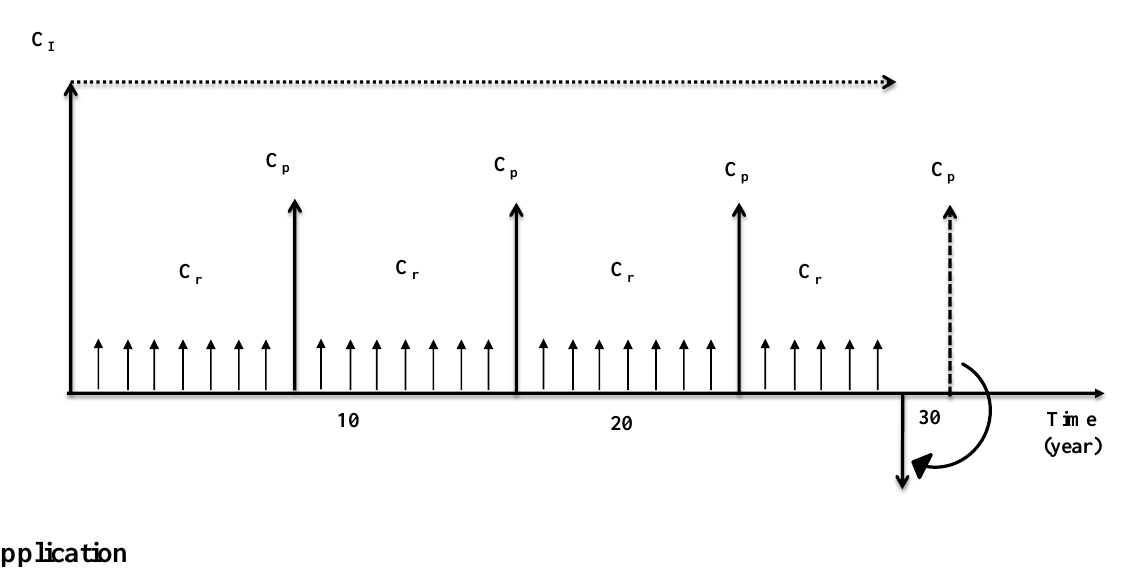
Figure 2. Illustration of the final value